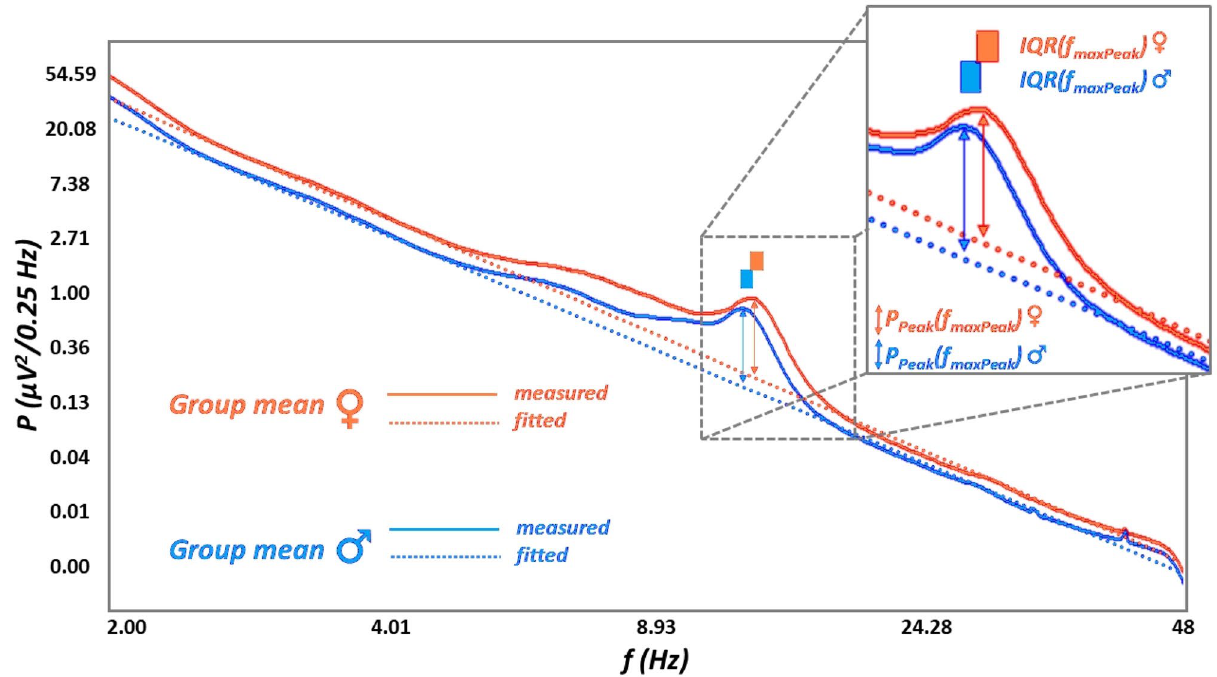
Figure 4. Women vs men differences in measured and parametrized mean NREM sleep EEG spectral power at electrode location C4. The natural logarithm of pectral power was averaged in women and men (continuous lines), as where individual fits (dotted lines) acoording to our current method (see details in section “Methods”). Note the overall amplitude differences (women > men), as well as the higher spectral peak frequencies (f maxPeak ) in women and the lack of differences in spectral peak amplitudes (P Peak (f maxPeak )). IQR interquartile